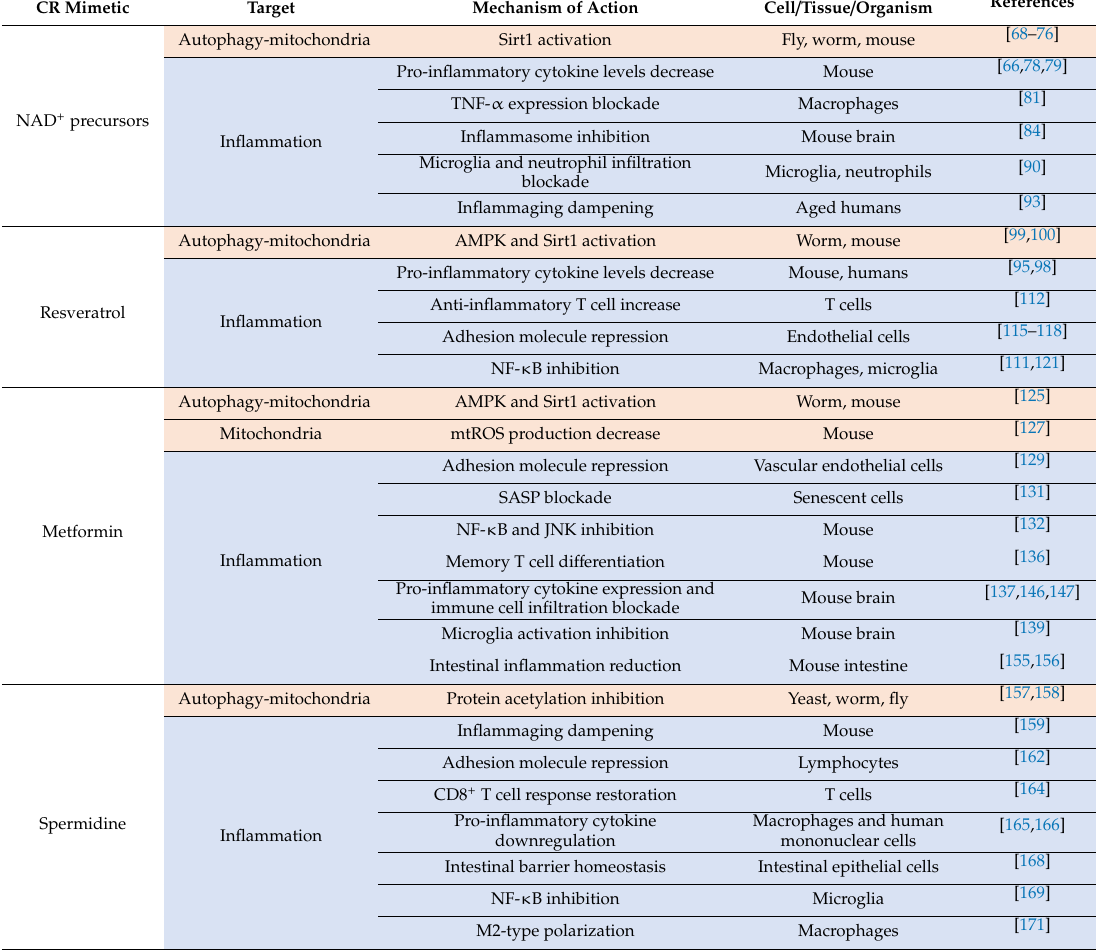
Table 1. Mechanism of action of CR